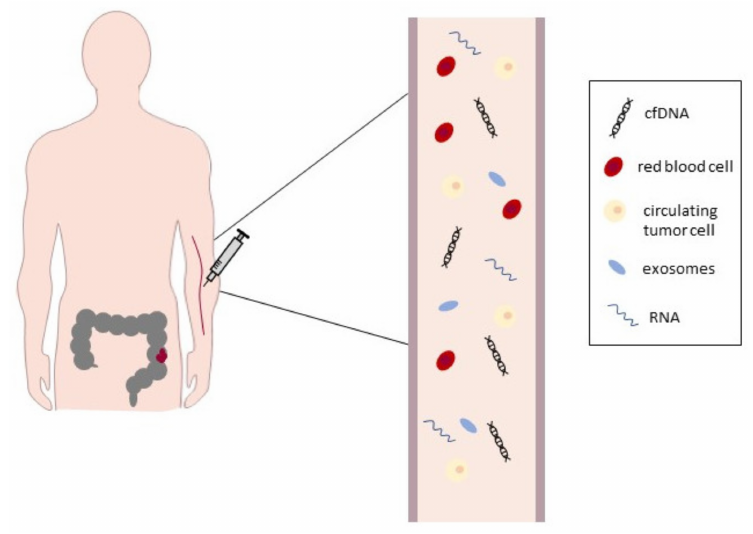
Figure 1. A liquid biopsy for solid tumors. A literature scan of the last few years revealed an enormous increase in liquid biopsy-based analyses